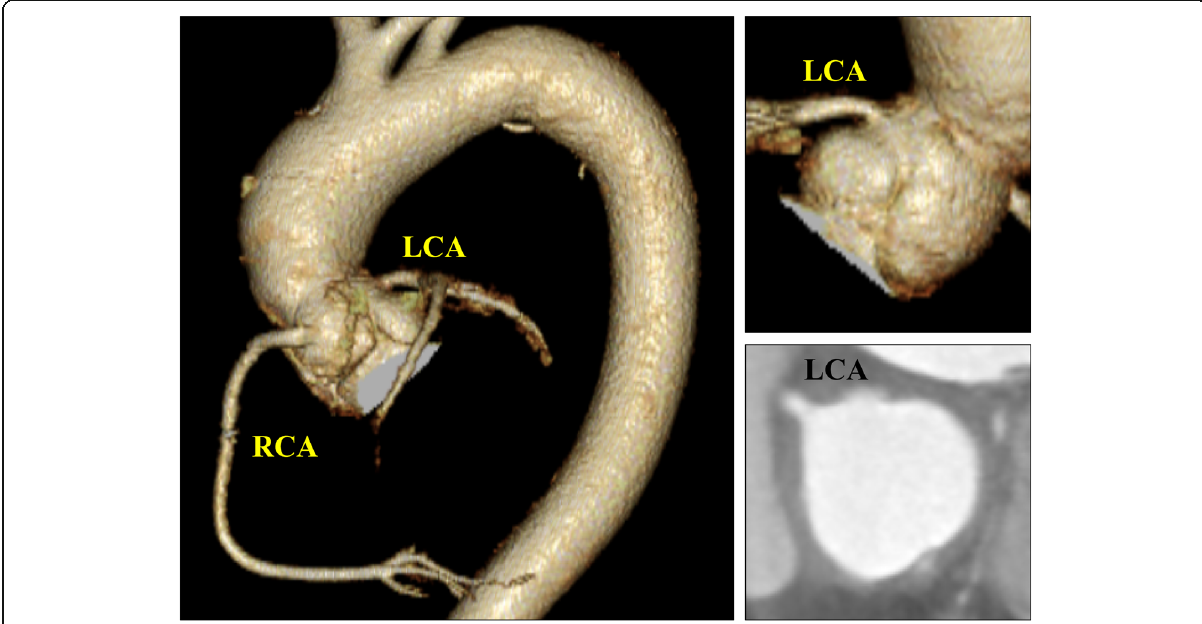
Fig. 3 Computed tomography taken 2 years after the operation. There was no distortion or stenosis associated with the covered graft at the left main coronary artery trunk. RCA: right coronary artery; LCA: left coronary